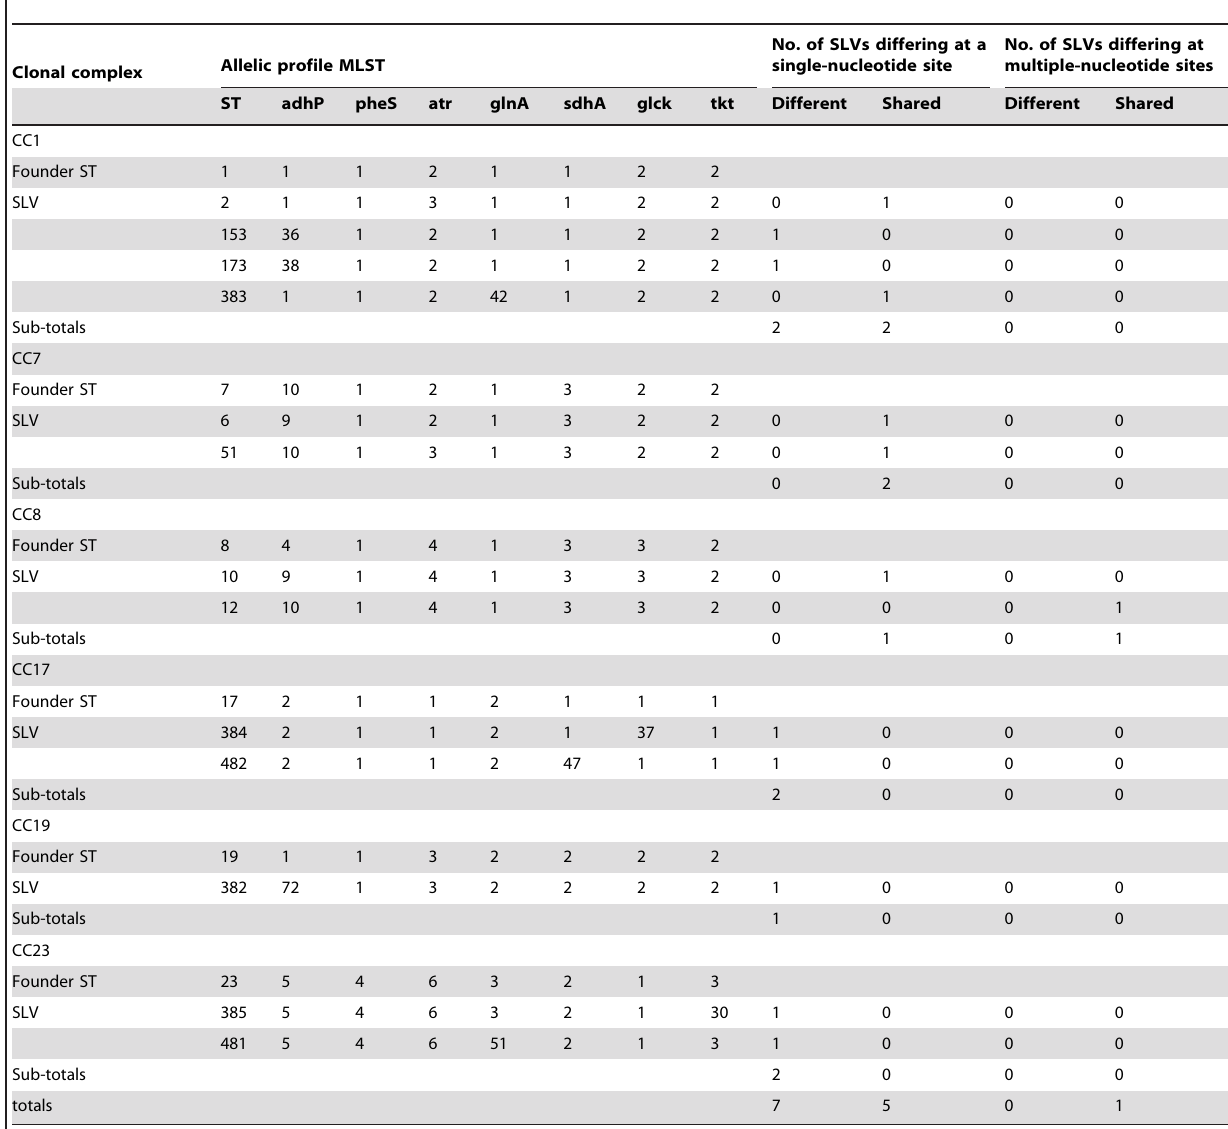
Table 5. Distribution of the SLVs of the major clonal complexes as a function of difference in the number of nucleotides (one or more) with respect to the sequence of the founder sequence